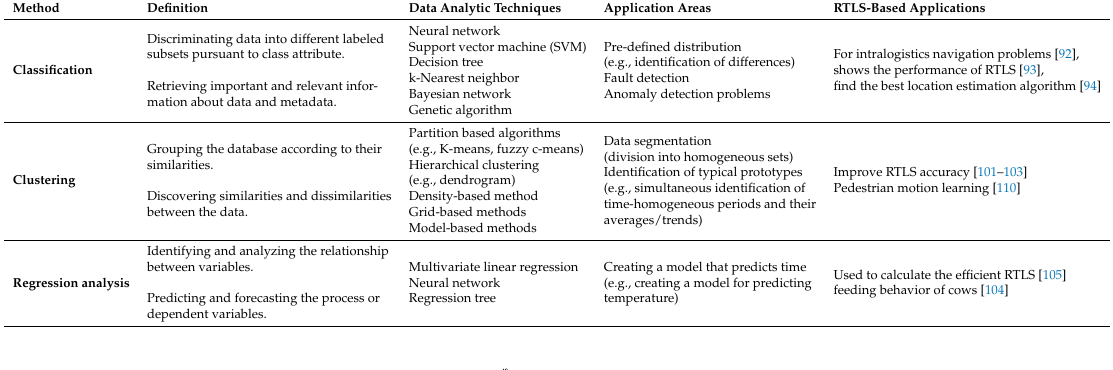
Table 5. Data mining techniques and areas of RTLS-based application.